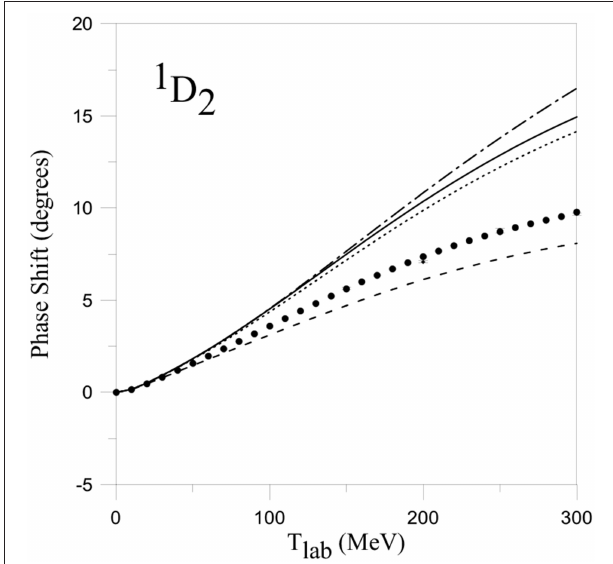
FIGURE 7 | NN 1 D 2 phase-shift. Solid, dashed, and dotted lines have the same meanings as in Figure 4A . Dashed-dotted line represents the result without exchange kernels. Reprinted figure with permission from Entem et al. [ 52] Copyright (2000) by the American Physical Society.